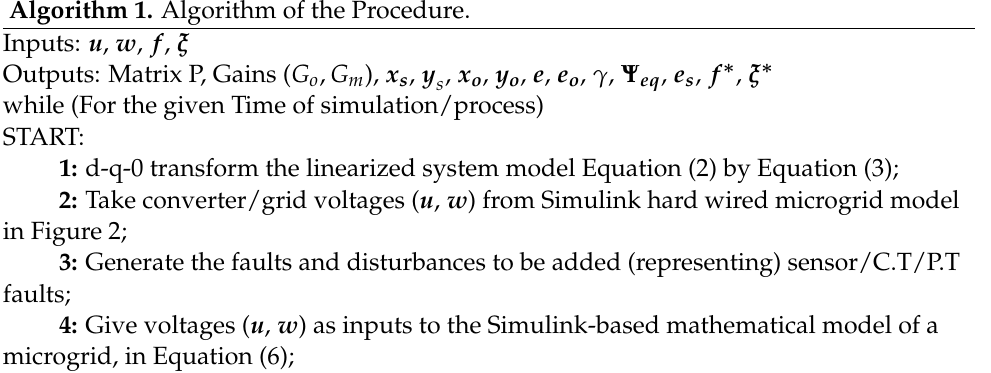
Algorithm 1. Algorithm of the